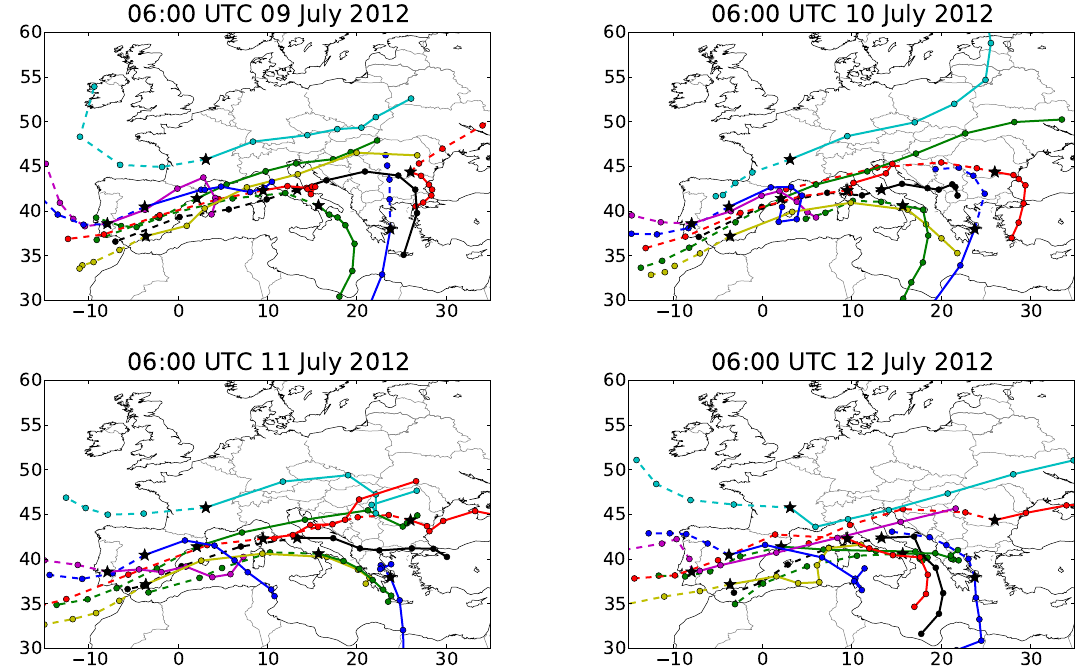
Figure 6. Backward (resp. forward) trajectories of 48 h (resp. 72 h) at lidar site locations (black stars) at 2 km a . g . l . ending (resp. starting) at 06:00 UTC 9 July 2012, 06:00 UTC 10 July 2012, 06:00 UTC 11 July 2012 and 06:00 UTC 12 July 2012. Data are from the HYSPLIT Model. Dashed (resp. solid) lines indicate backward (resp. forward) trajectories, where the 12 h spacing is given by the discs. The backward trajectories pertain to the source attribution problem of the lidar measurements whereas the forward trajectories show the propagation of the DA updates around lidar locations.